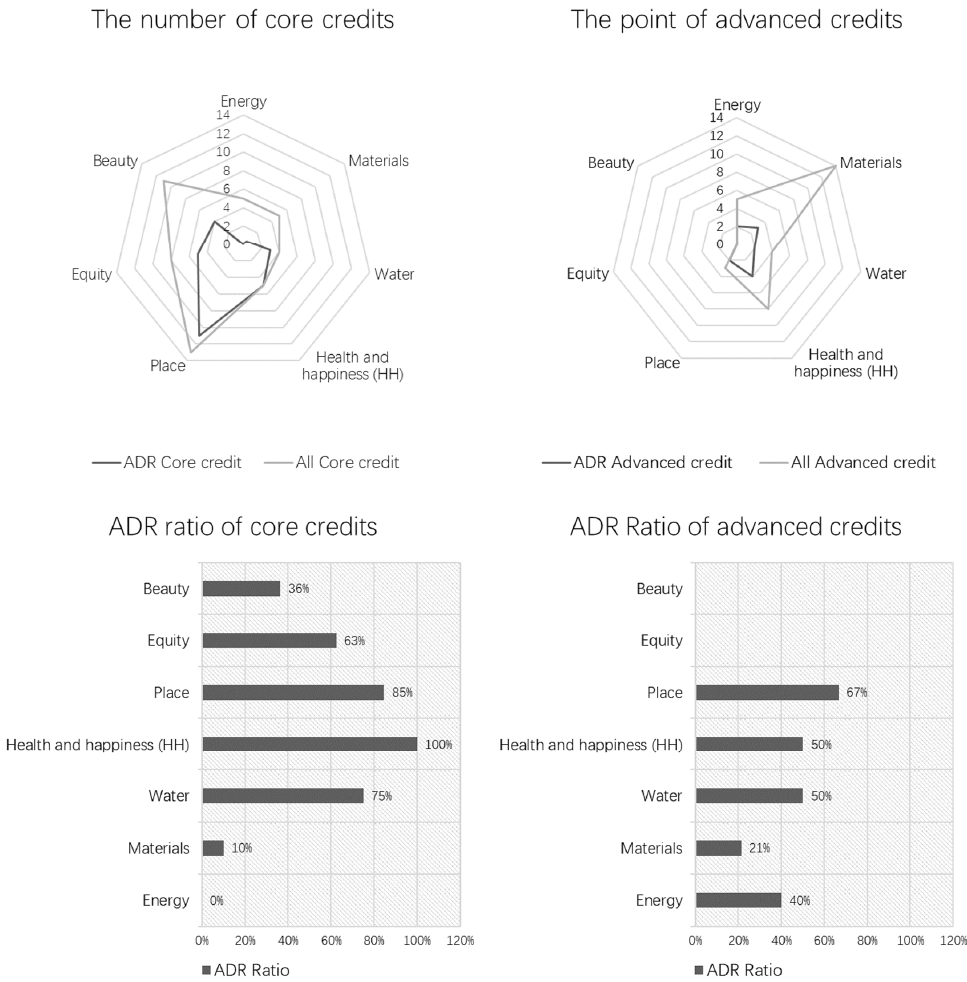
Figure A6. Breakdown of the number of core credits and advanced credits, and ADR ratio in diverse categories of LBC. (Source: by the author).